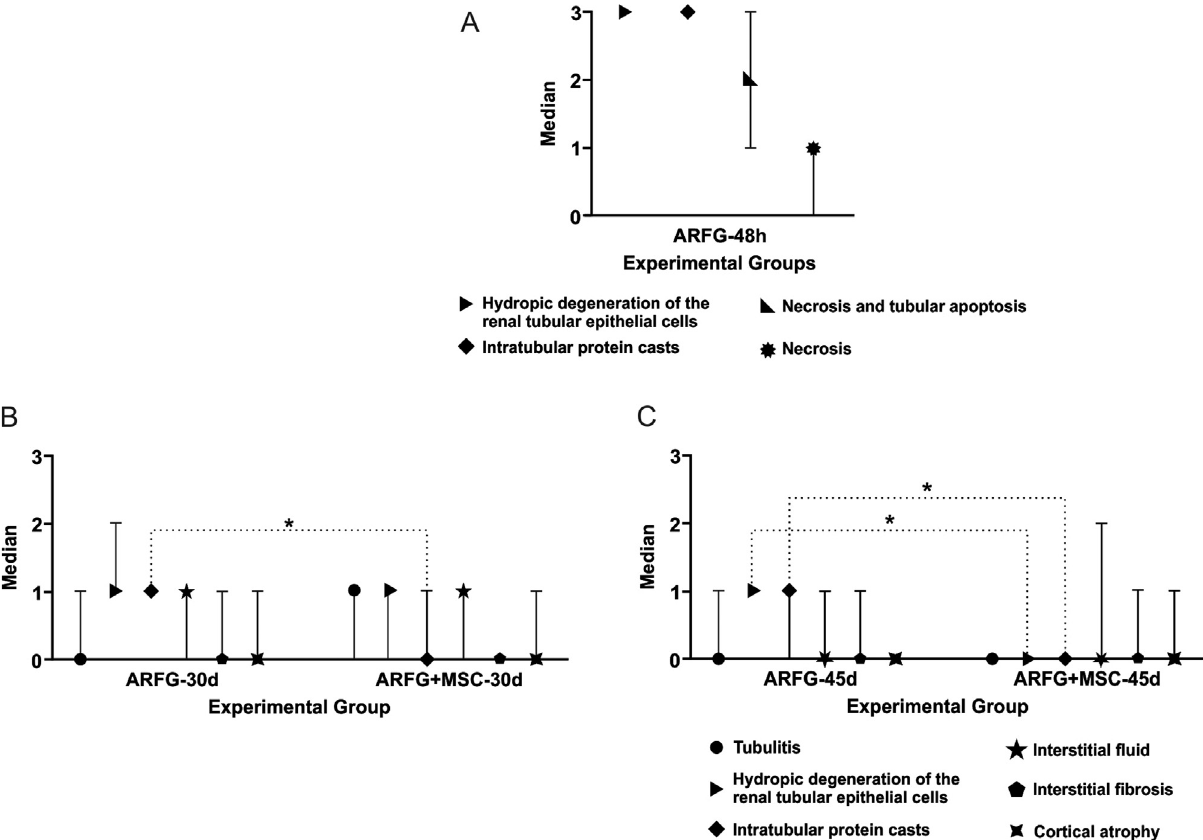
Figure4 -DatafromthehistopathologicalcutsaccordingtheBanff97classification.A)ARFG-48h:Acuterenalfailuregroup;animalsweretreatedwith cisplatin, evaluated seven days before and 48 h after the administration of the chemotherapy. B and C) ARFG: Acute renal failure group; animals treated with cisplatin. ARFG+MSC: In this group, MSC were transplanted to animals with acute renal failure 24 h after the chemotherapy administration. B) 30d – animals evaluated after 30 days of the administration of the chemotherapy. C) 45d – animals evaluated after 45 days of the administration of the chemo- therapy. Statistical analysis: Mann-Whitney, *statistically significant differences, p (cid:3)